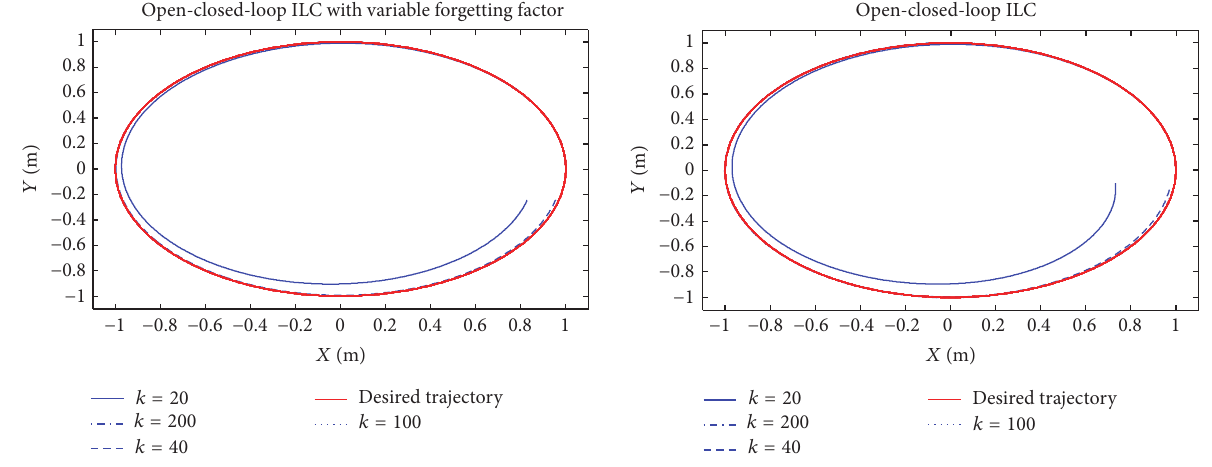
Figure 2: Desired and actual position trajectories.